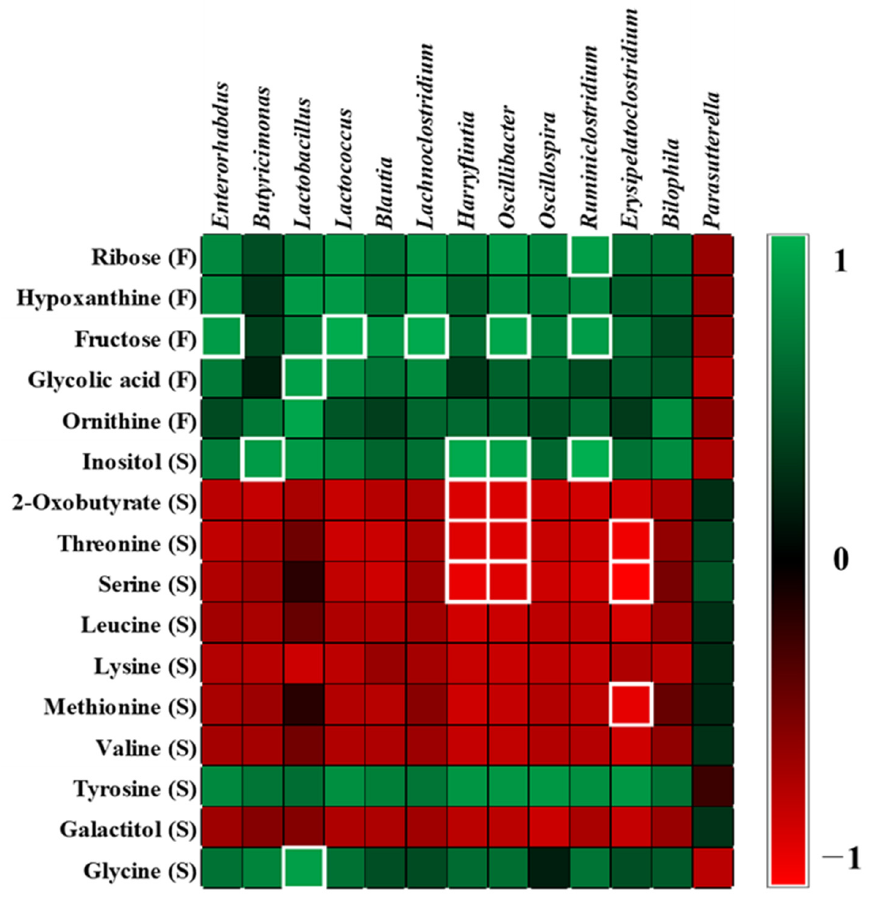
Figure 6. The heat map shows correlation between the identi fi ed metabolites and microbiota. R − val- ues of 0.7 or more are highlighted with white borders. A false discovery rate of 5% was applied to all tests to correct for multiple testing.